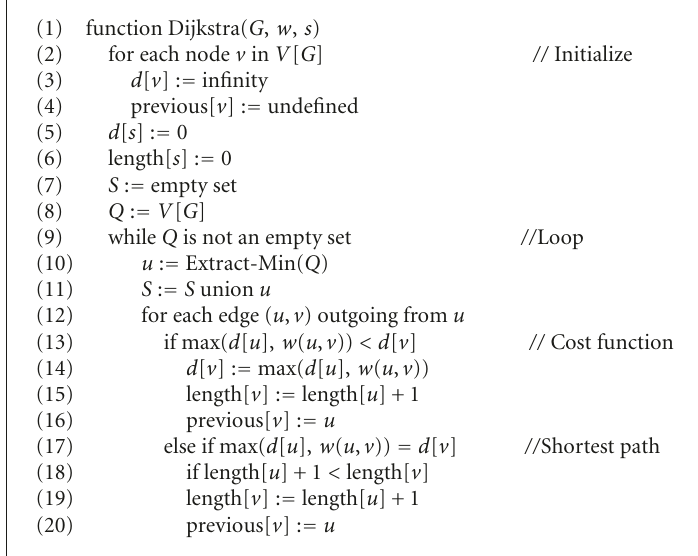
Algorithm 1: Modified Dijkstra algorithm.